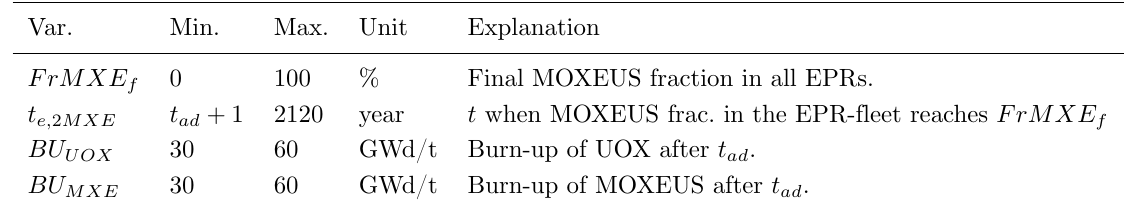
Table 2. Ranges of input variables in the adaptation scenario SCN SFR2MOXEUS . Var. Min. Max. Unit Explanation FrMXE f 0 100 % Final MOXEUS fraction in all EPRs. 2120 year 60 GWd/t Burn-up of UOX after t ad . GWd/t Burn-up of MOXEUS after t ad